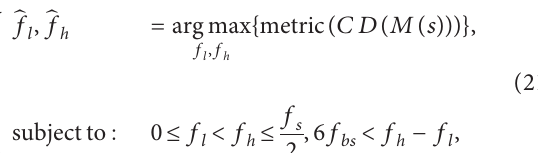
Figure 8: Impulses extracted using UC-DLA for different values of k . (a) The simulation signal s (c–h) impulses extracted using UC-DLA for different values of target